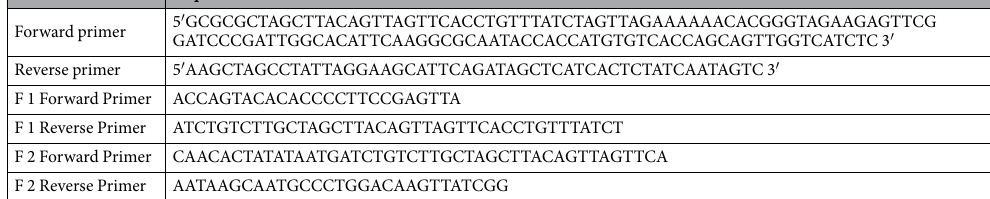
Table 3. Sequence of the primers used in the construction of rAF-IL12. * Abbreviation: F =